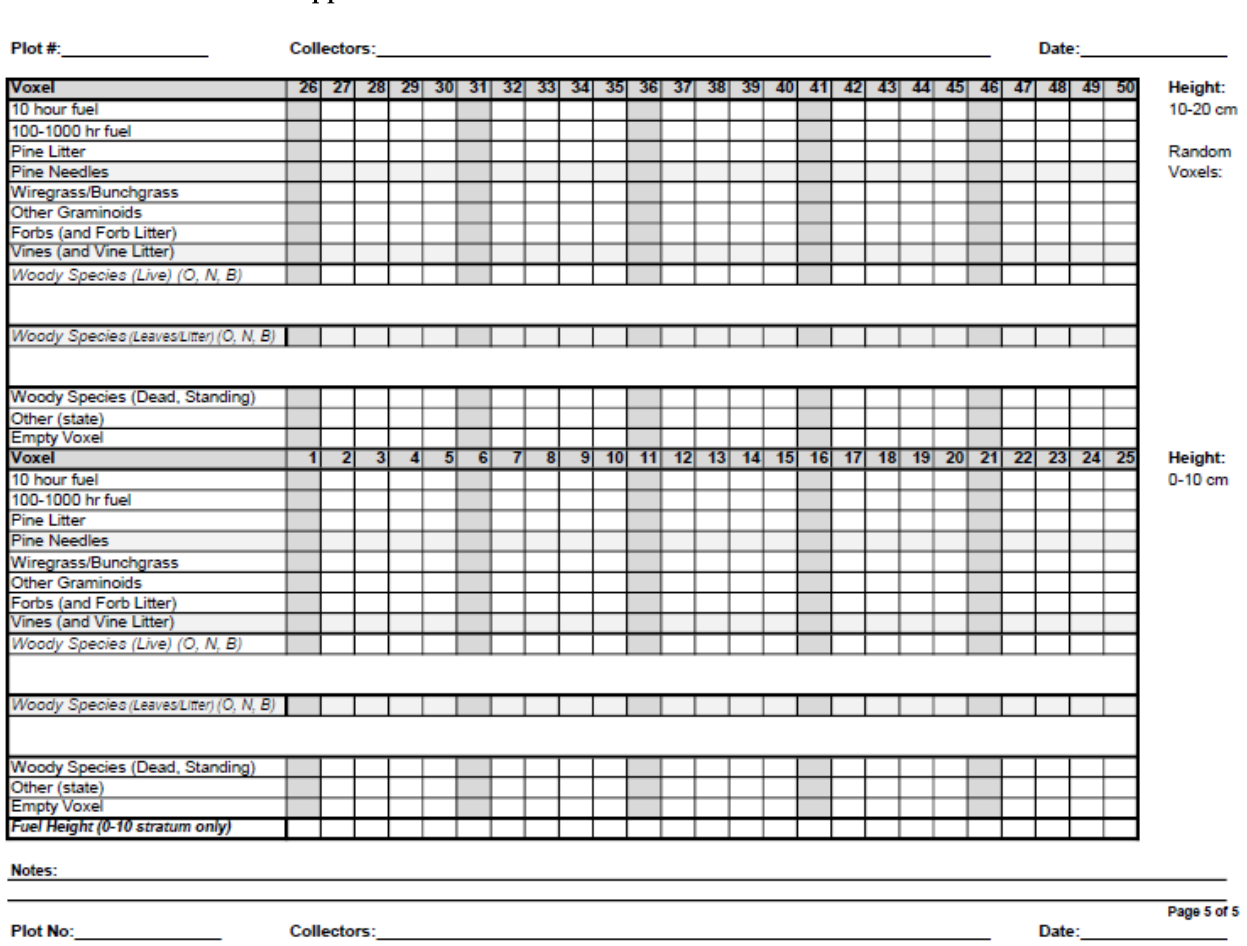
Figure A1. Example of data sheet used to collect voxel data for fuel types. Wiregrass/Bunchgrass, Other Graminoids, Forbs, and Vines were aggregated into the herbaceous fuel category. Woody Species (Leaves/Litter) represented the woody litter category. Woody Species (Live) represented the live woody category. Table A1 . Data used in this study. Burn Number represents which arbitrary burn unit was sampled while Plot represents an individual clip plot in each burn unit. The “Pre” preceding the plot number indicates a Preburn plot while “Post” preceding the plot number represents a Postburn plot. The number in Plot represents paired plots. For example, within the same Burn Number, Pre2 and Post2 are paired plots. Burn Status describes when the data was taken, where Pre = before burn and Post = after burn. Therefore, Mass and Volume were collected before the burn for every preburn plot. While mass was only recorded after the burn for postburn plots, volume was recorded both before and after the burn. Height describes at which height stratum the data was collected. For Mass and Volume, H = Herbaceous, LW = Live Woody, and WL = Woody Litter. Further descriptions of the methodology are in the main text.